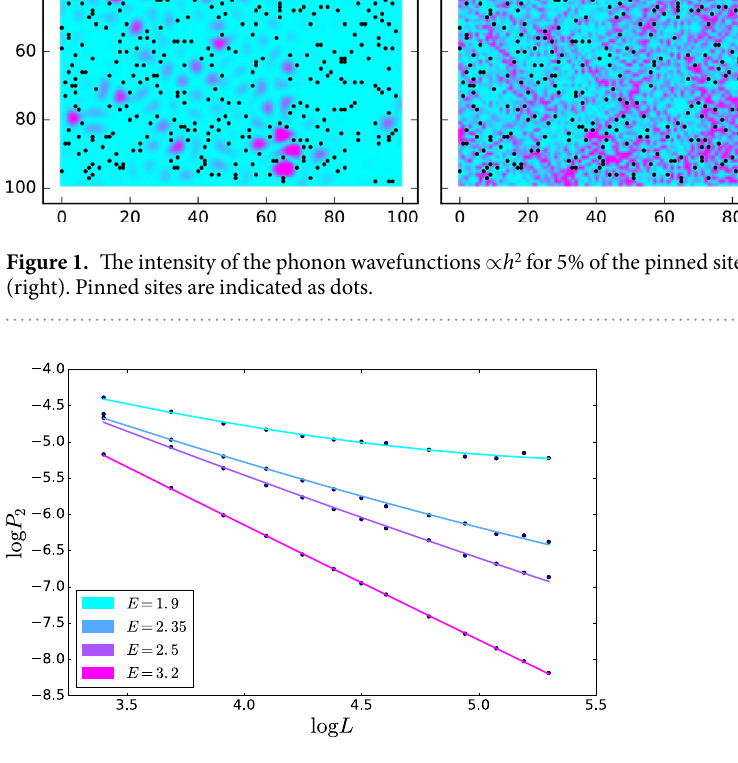
Figure 2. Scaling of the IPR with the system size for 20% of the pinned sites and several values of energy E . For the smallest energy the effect of the WL correction to g ph ( L ) is clearly